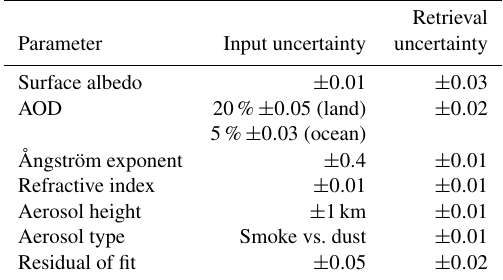
Table 1. Estimates of the uncertainty in retrieved